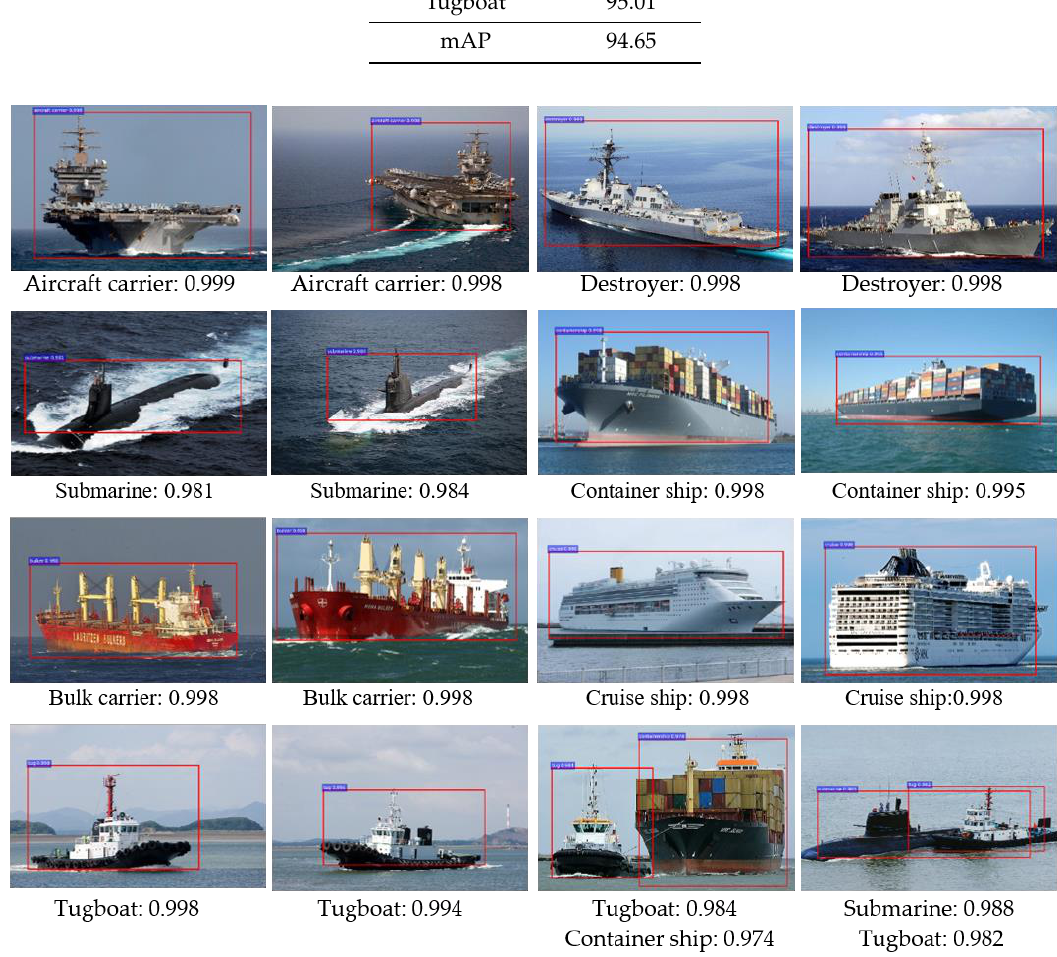
Figure 6. Results of the ship detection using the Faster R-CNN based on the test images.